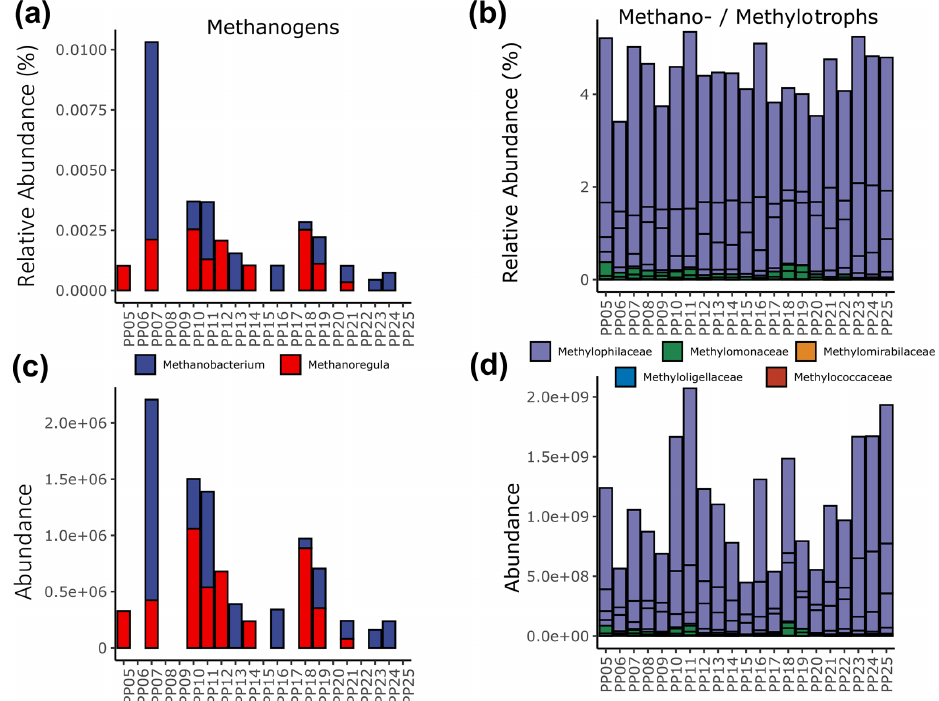
Figure 6. Relative (a and b) and pseudo-absolute (c and d) abundances of putatively methanogenic archaeal genera (a and c) and methy- lotrophic bacterial families (b and d) . An expanded version that includes only the methanotrophs is available in the Supplement (Fig. S9).